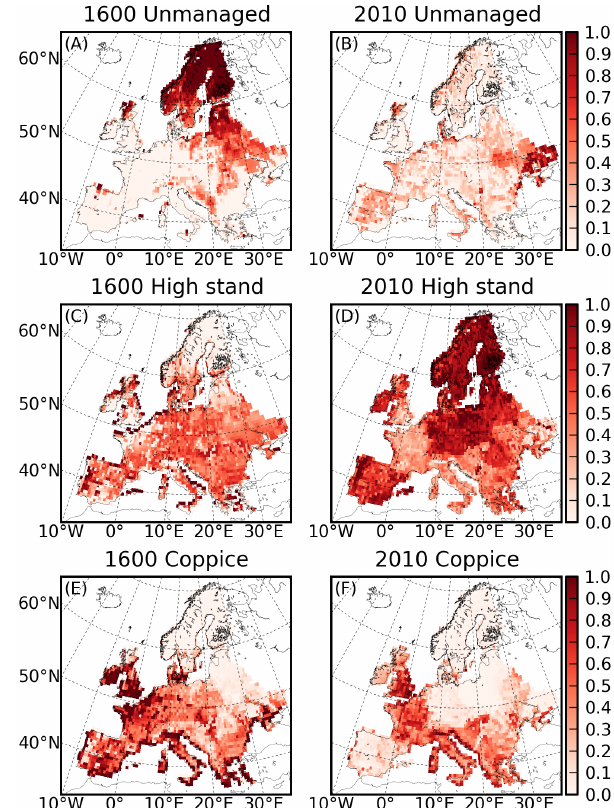
Figure 6. Distribution of management strategies over Europe. (a) Unmanaged forests in 1600 and (b) in 2010. (c) High-stand forests in 1600 and (d) in 2010. (e) Coppice management in 1600 and (f) in 2010. The color bar shows the fraction of the forest managed by a given strategy. Pixels along the coastlines often contain few forests, frequently resulting in the entire pixel being under a single management